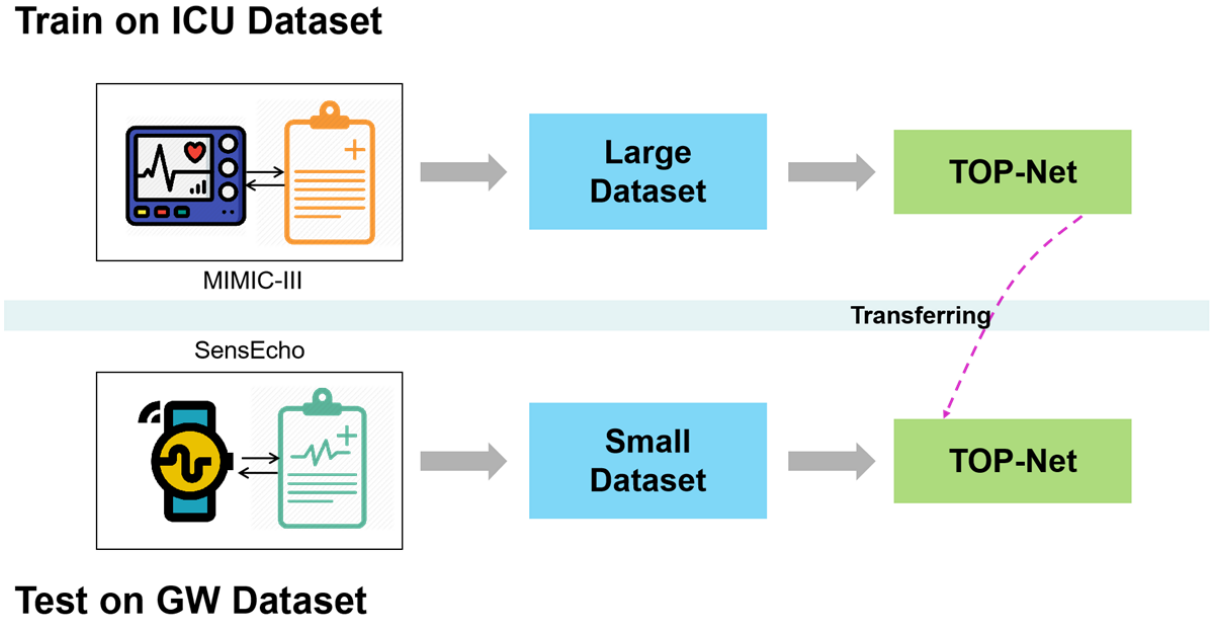
Figure 1. The process of developing and transferring the early tachycardia onset model, TOP-Net. GW: general ward; ICU: intensive care unit.